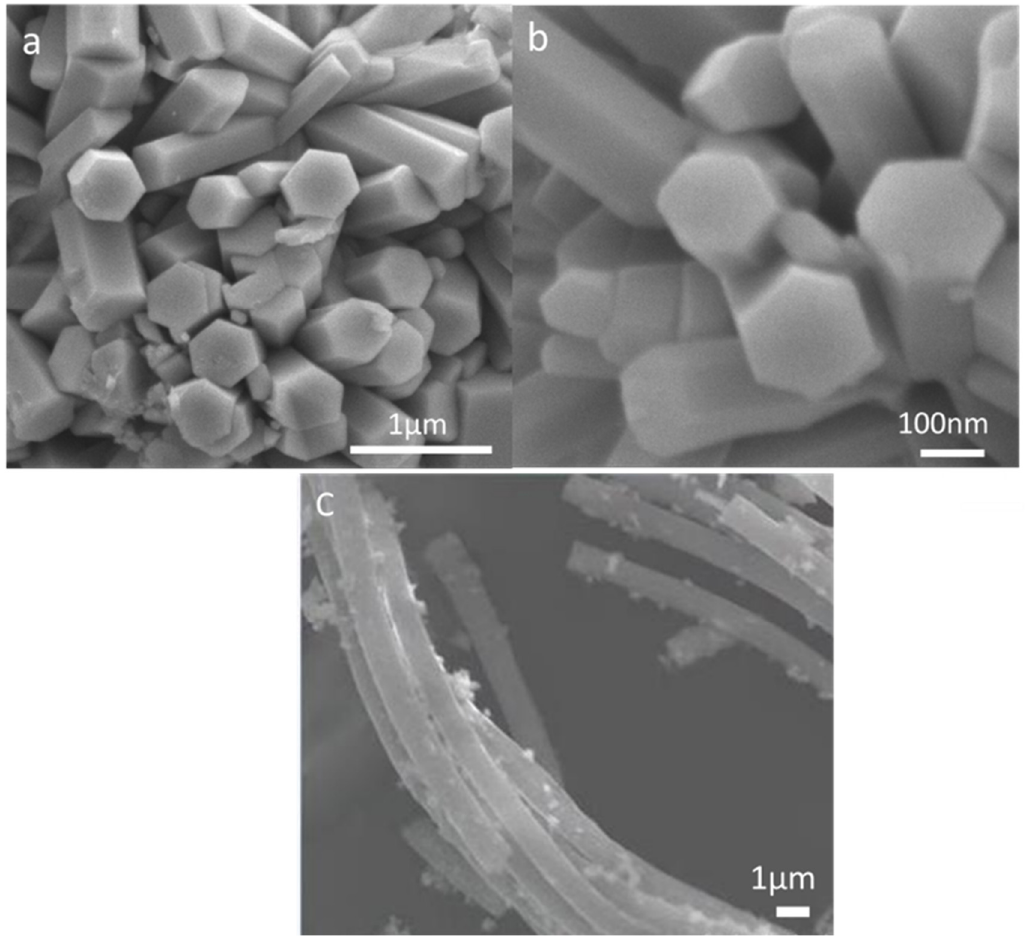
Figure 2. SEM images of optimally synthesized MoO 3 with magnifications of ( a ) × 30,000 and ( b ) × 70,000 (optimal synthesis conditions: pH = 1, reaction temperature: 90 ◦ C, medium stirring rate: 350 rpm). ( c ) SEM images of synthesized MoO 3 with magnification of × 7500 (synthesis conditions: reaction temperature: pH = 2.5, T = 90 ◦ C, medium stirring rate: 350 rpm).